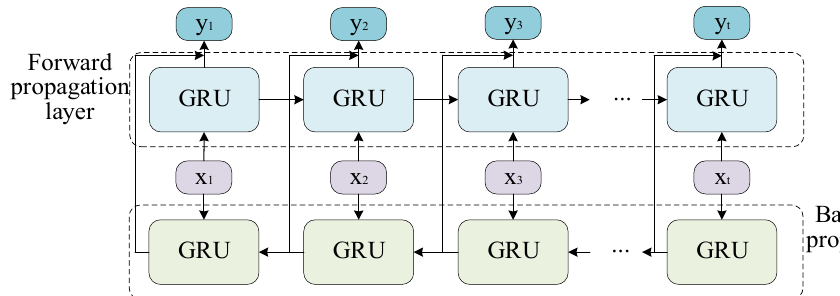
Figure 5. BiGRU structure diagram.